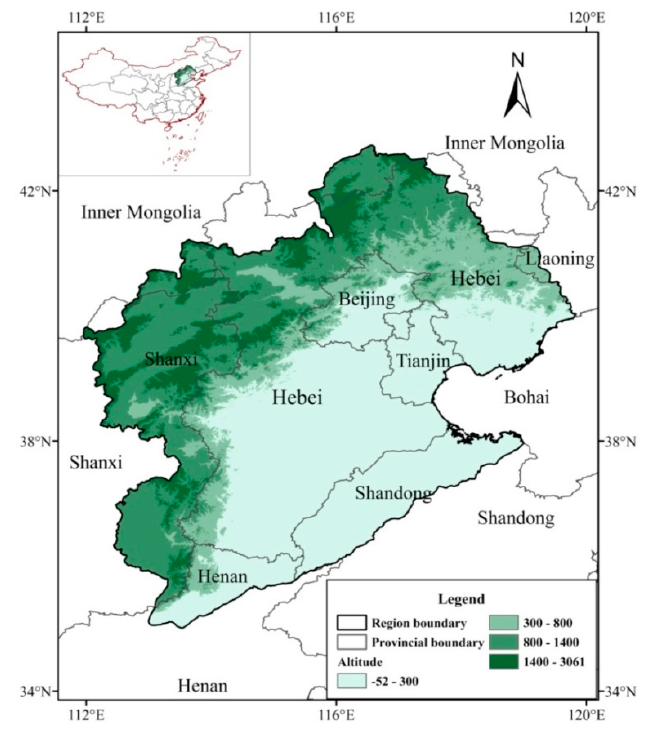
Figure 1. Location and topography of the HRB.